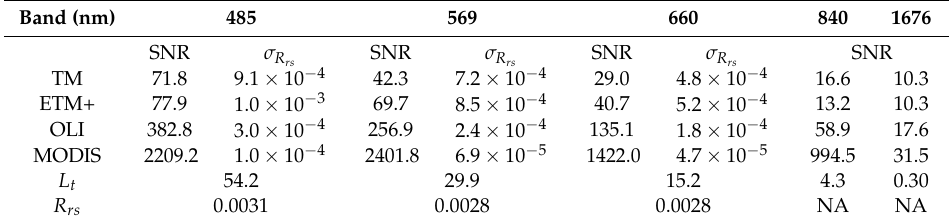
Table 6. The SNR, TOA radiance ( L t ), and the uncertainties in R rs ( σ R ) associated with TM, ETM+, rs OLI, and MODIS. σ R represents one standard deviation corresponding to the R rs distributions derived rs from many SeaDAS runs for a small OLI subset. Note that the aerosol removal was conducted using the 840–1676 band combination and OLI’s SNR from [74] were scaled to provide comparable SNRs estimated for typical radiances reported in Reference [5] for TM, ETM+, and MODIS. The units for L t and σ R are wm − 2 µ − 1 sr − 1 and sr − 1 , respectively. Band centers refer to TM rs